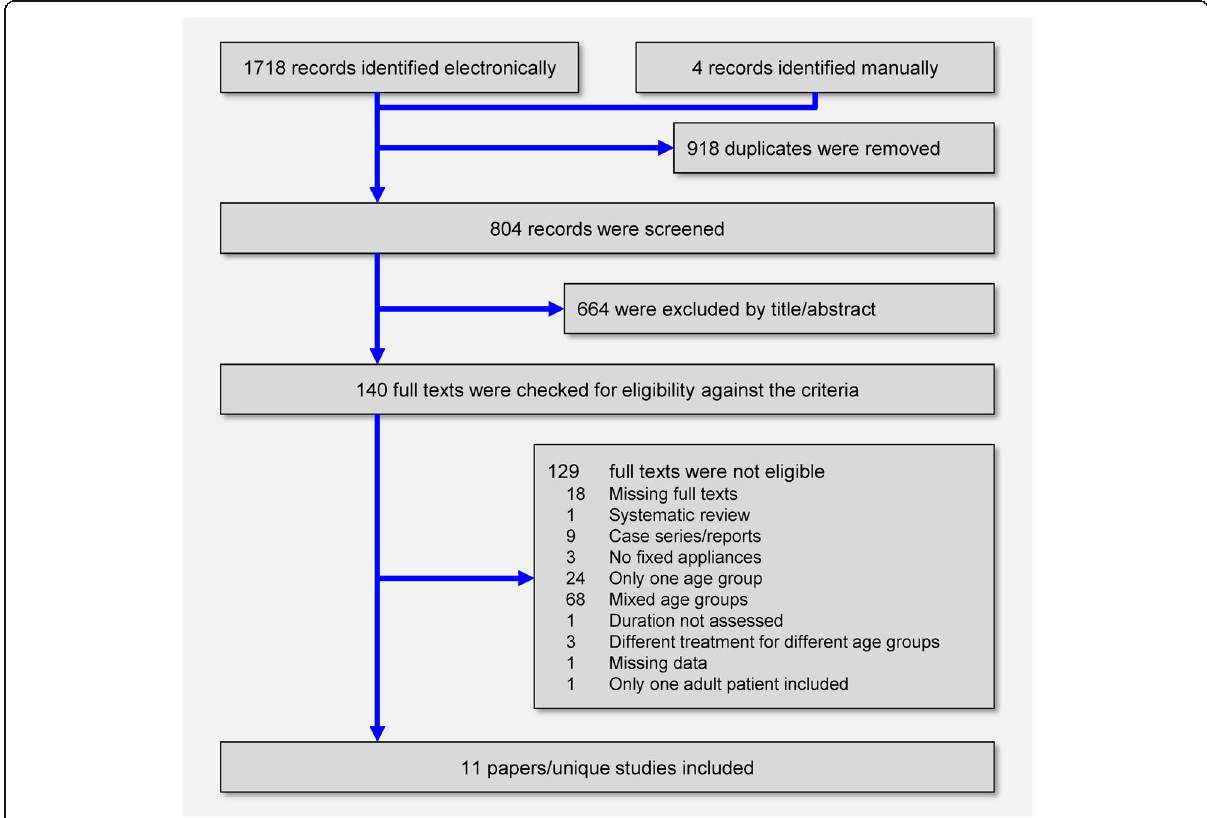
Fig. 1 PRISMA flow diagram for the identification and selection of eligible